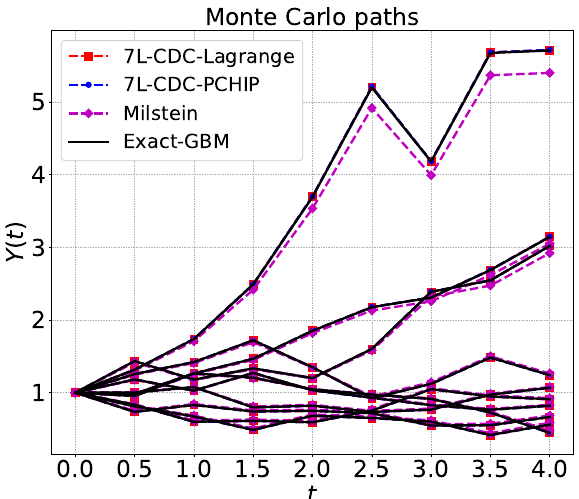
Figure 6. Paths generated by 7L-CDC: time step ∆ t = 0.5, GBM with σ = 0.3, r = 0.1, Y 0 = 1.0. The paths are with Chebyshev interpolation, which are not plotted, are identical to ones from Lagrange in this case.